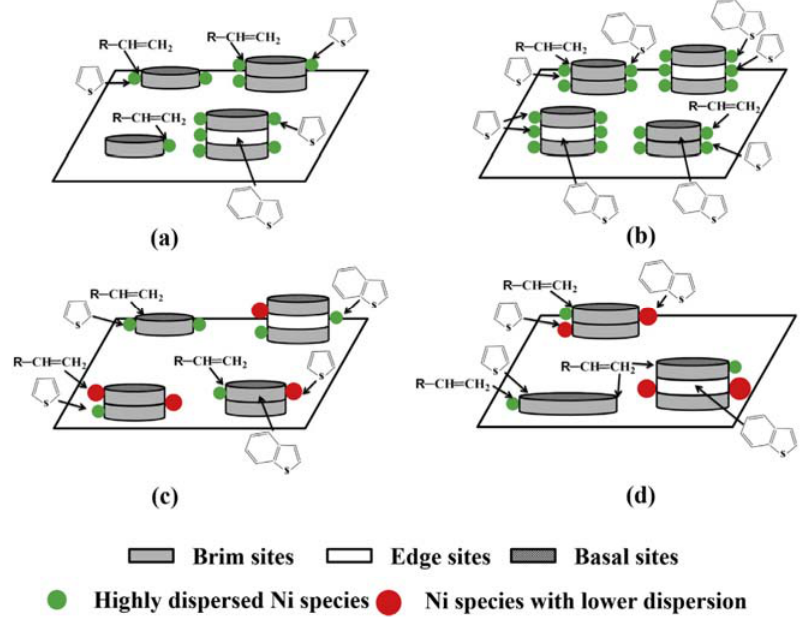
Figure 9. Schematic representation of different supported Ni promoted WO 3 /Al 2 O 3 catalysts. NiO content: ( a ) < 4.8 wt.%, ( b ) 4.8 wt.%, ( c ) > 4.8 wt.%, ( d ) 4.8 wt.% (impregnation method). Reproduced